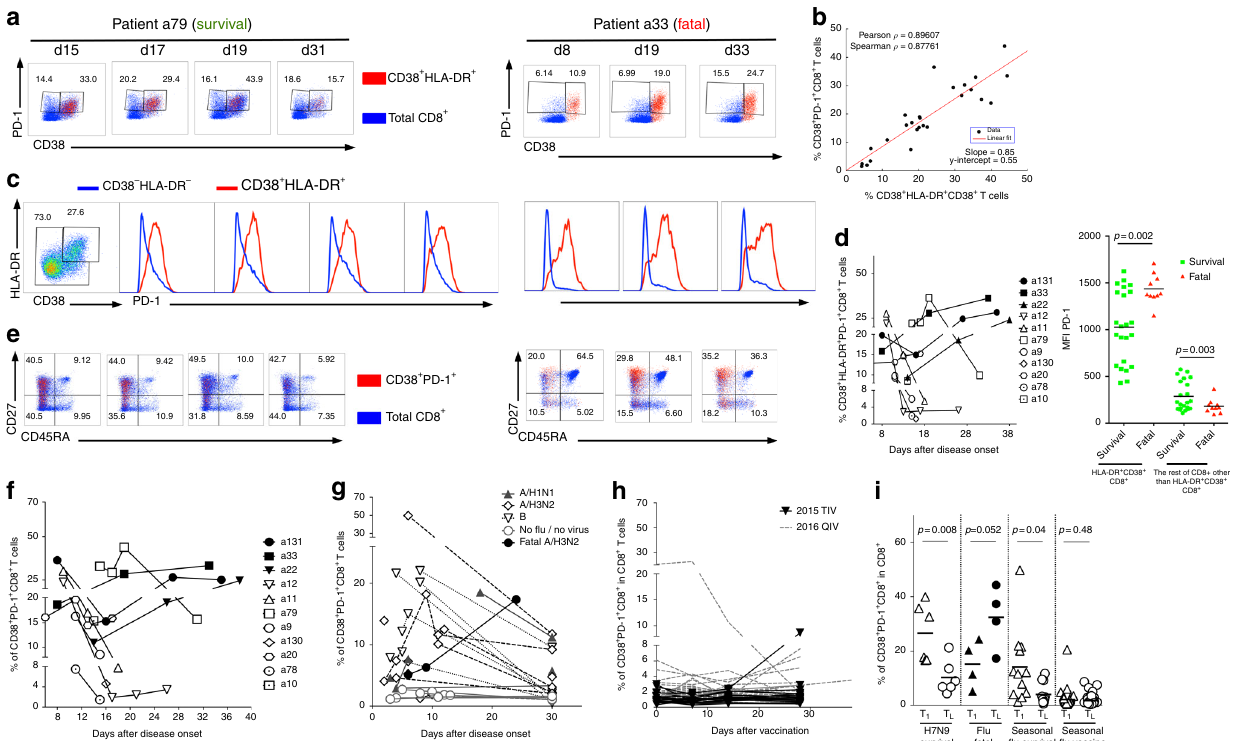
Fig. 2 Dynamics of CD38 + HLA-DR + PD-1 + CD8 + cells segregate H7N9 disease outcome. a Representative FACS plots of PD-1 expression within the CD38 + HLA-DR + CD8 + T cells (in red) and the total CD8 + T cells (in blue) in patient a79 (recovered from H7N9) and patient a33 (died from H7N9). b Correlation between the frequency of CD38 + PD-1 + CD8 + T cells and a proportion of CD38 + HLA-DR + CD8 + T cells, as measured by Spearman test. c Representative histograms of PD-1 expression within CD38 + HLA-DR + CD8 + T cells (red) and the remaining non-CD38 + HLA-DR + CD8 + T cells (blue). d High and prolonged expression of PD-1 in patients who died, as triple-positive CD38 + HLA-DR + PD-1 + and mean fl uorescence intensity (MFI) of PD-1 expression within CD38 + HLA-DR + CD8 + T cells and non-CD38 + HLA-DR + CD8 + T cells for survivals and fatal cases (a standard two-tail Student ’ s t -test), with samples from individual patients being acquired on an LSR Fortessa on different days. e CD45RA and CD27 pro fi les on CD38 + PD-1 + CD8 + T cells (in red) and on total CD8 + T cells (in blue). f Similar to CD38 + HLA-DR + CD8 + T cells, the frequency of CD38 + PD-1 + CD8 + T cells declined with time in the H7N9 survival group, which was maintained or increased in H7N9 patients who died. The frequency of CD38 + PD-1 + CD8 + T cells was also analyzed in g patients hospitalized with seasonal pH1N1 (5 patients; dotted lines, solid triangles), H3N2 (10 patients in dashed lines, open diamonds), in fl uenza B (6 patients in dotted black lines, open triangles), non-in fl uenza/non-viral hospitalized patients (5 patients; gray lines, open gray circles), and 1 H3N2 patient with fatal outcome (black line, solid black circle); and h healthy individuals during inactivated in fl uenza vaccination in 2015 (18 individuals vaccinated with a trivalent (TIV) vaccine; black lines) and 2016 (27 individuals vaccinated with quadrivalent (QIV) vaccine; gray lines). i Frequency of CD38 + PD-1 + CD8 + T cells during the fi rst (T 1 ) and last time-point (T L ) of hospitalization or vaccination in H7N9 survival cases, fatal in fl uenza patients (3 H7N9, 1 H3N2); seasonal in fl uenza survival cases, and seasonal in fl uenza vaccinees. Means are shown as horizontal bars. Standard two-tail Student ’ s t -test was performed with indicated p